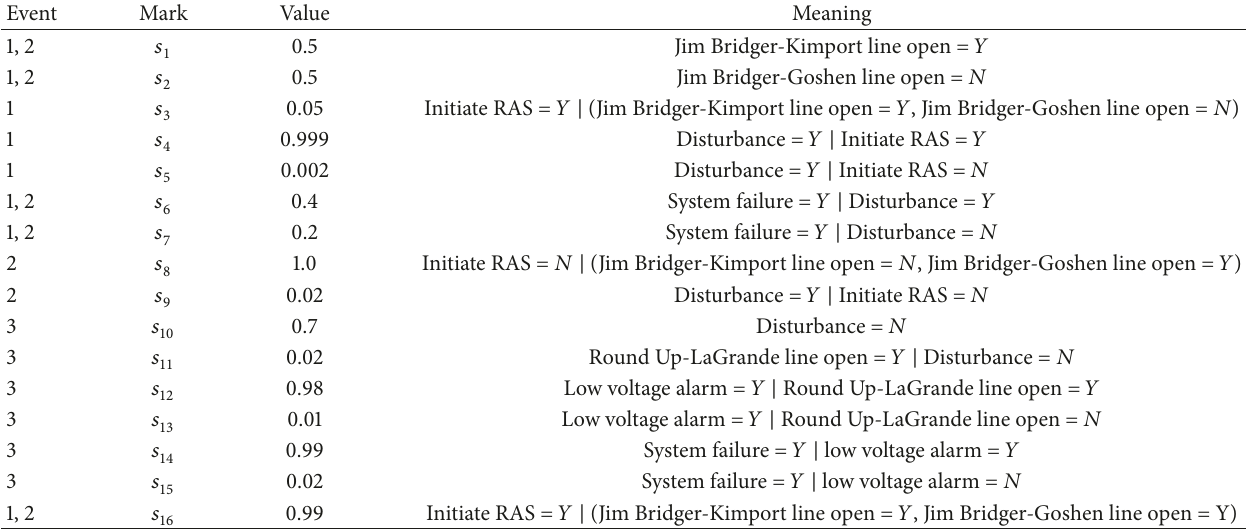
Table 4: 𝑆 -node labels for US blackout incidence BKBs.